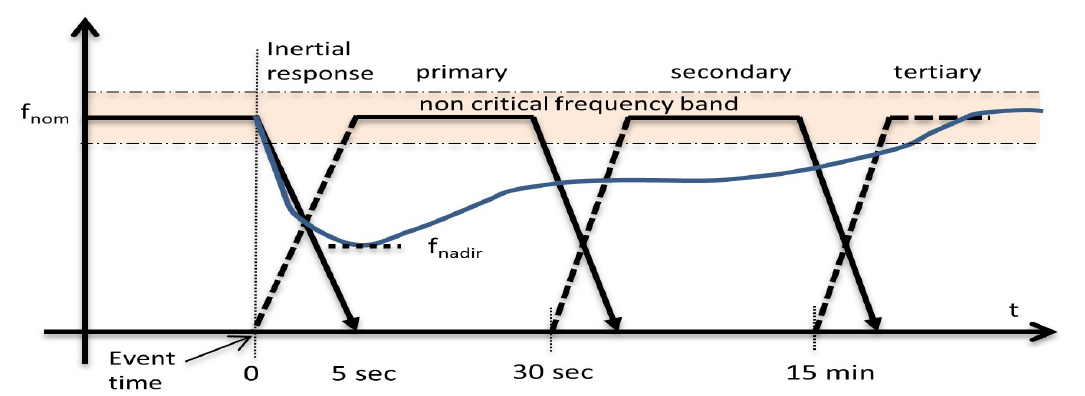
Figure 1. Frequency response stages by the European Network of Transmission System Operators for Electricity (ENTSO-E)